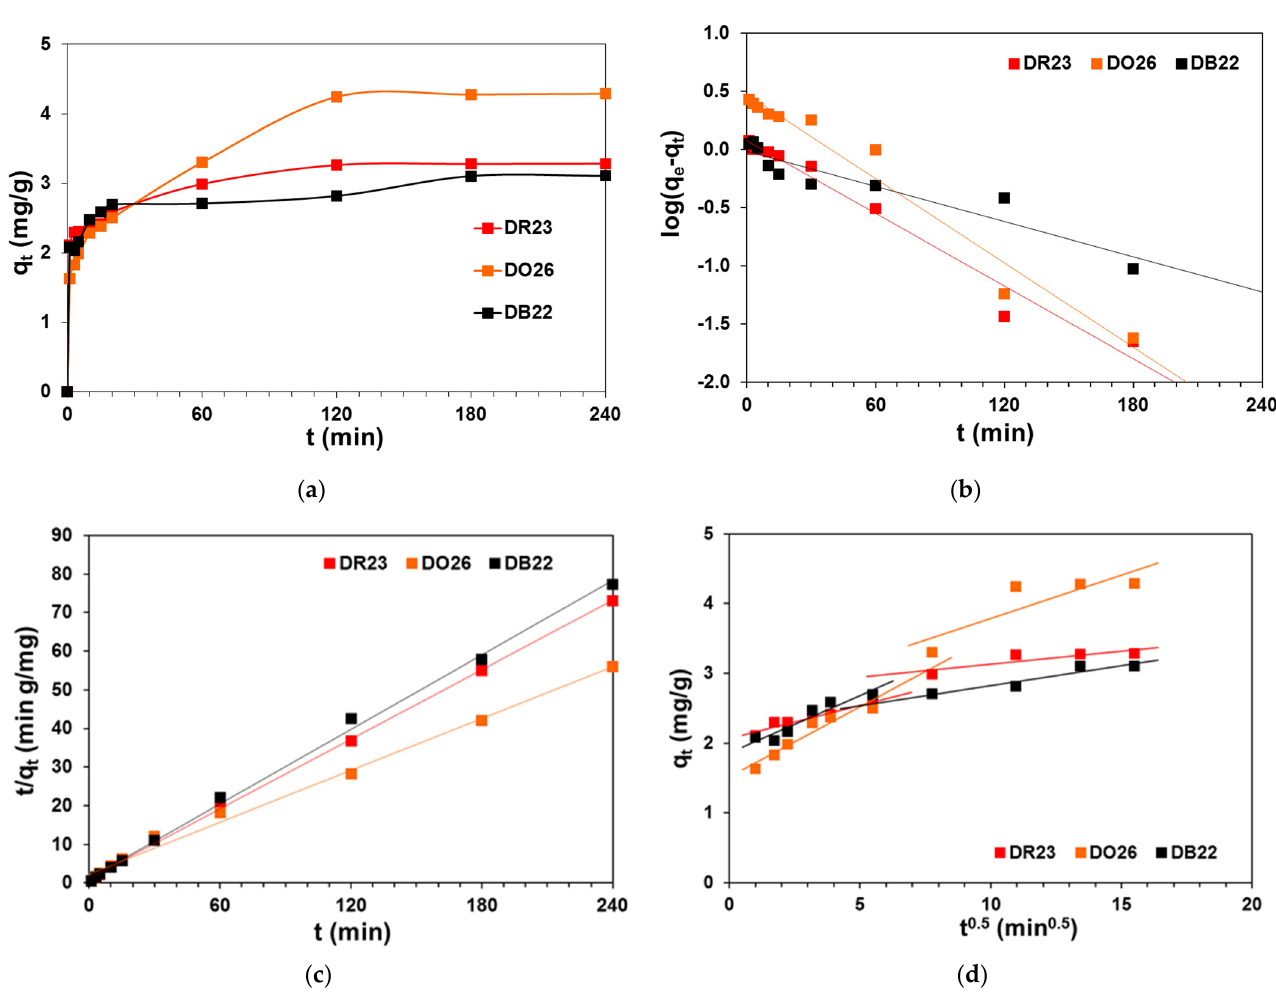
Figure 5. Kinetic plots for ( a ) direct dyes removal on A21 resin as well as ( b ) PFO, ( c ) PSO and ( d ) IPD model considering DB22, DR23 and DO26 dyes adsorption on A21 resin.